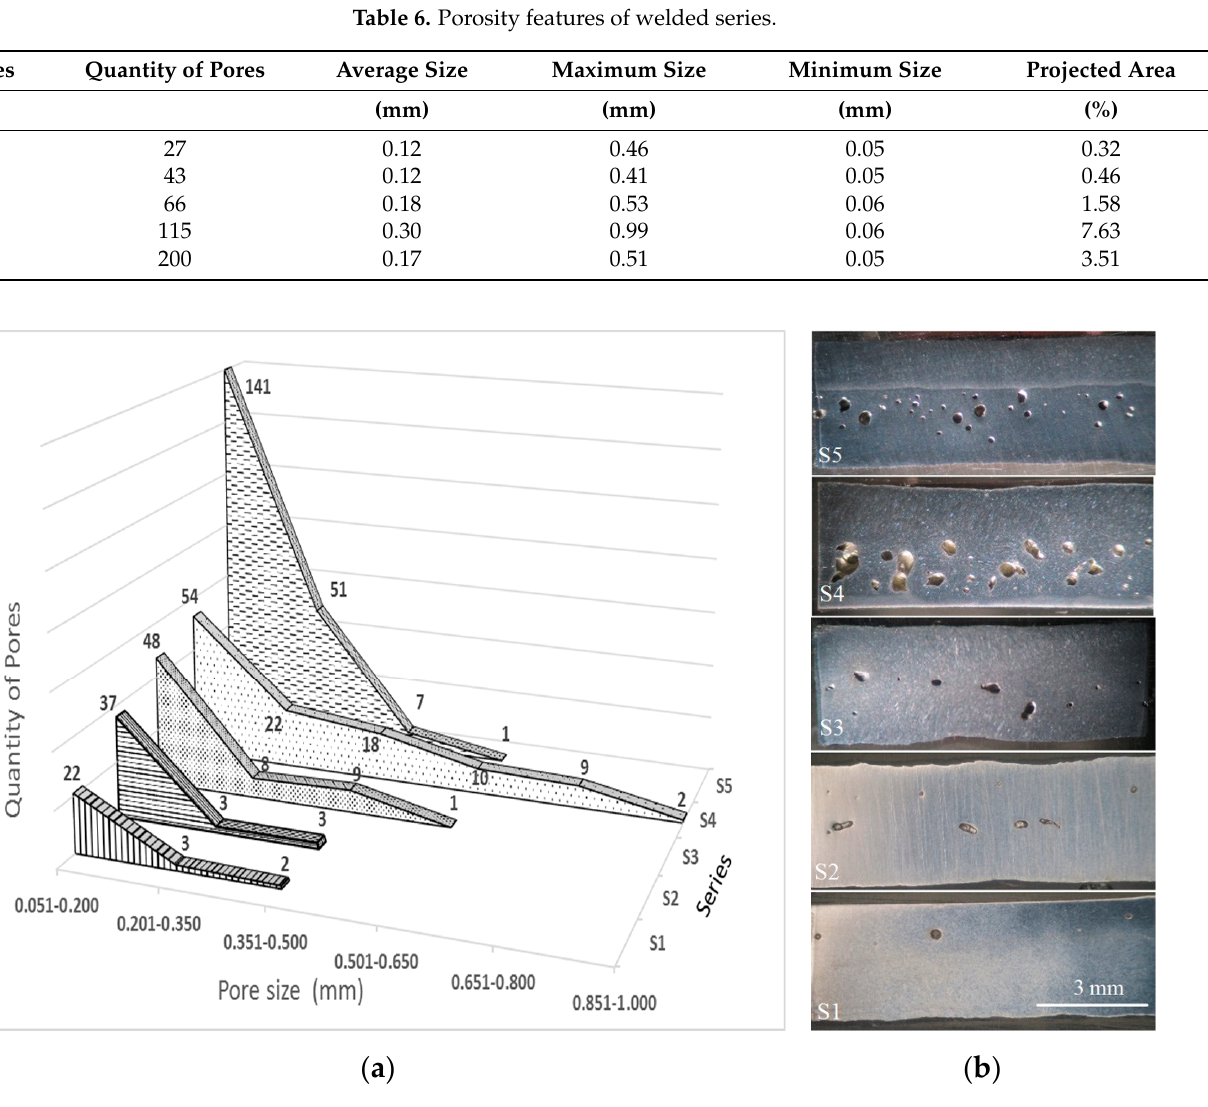
Table 6. Porosity features of welded series.